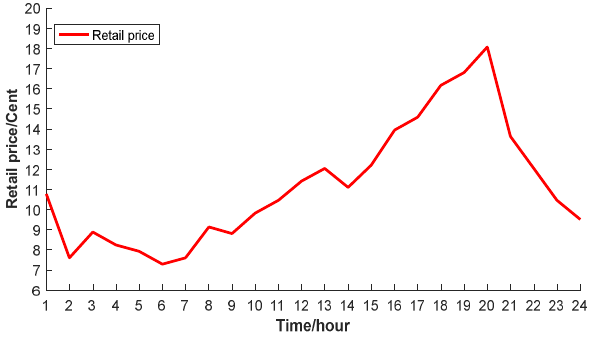
Figure 11 . The electricity retail price for 24 h. Figure 11. The electricity retail price for 24 h.